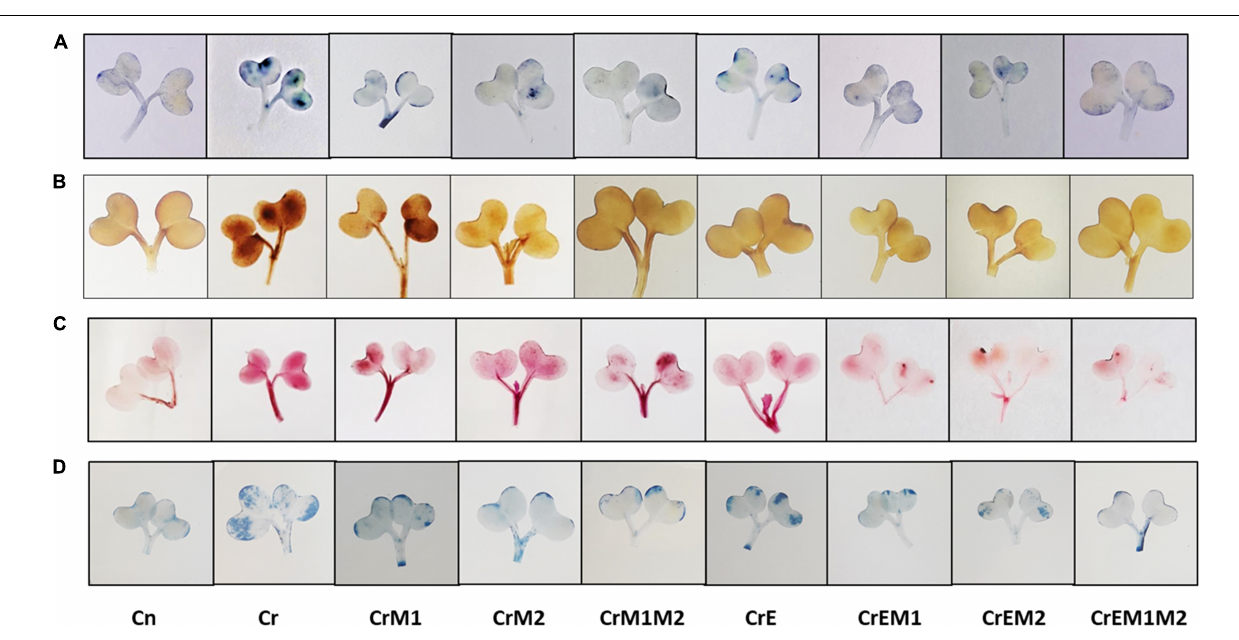
Frontiers in Microbiology |